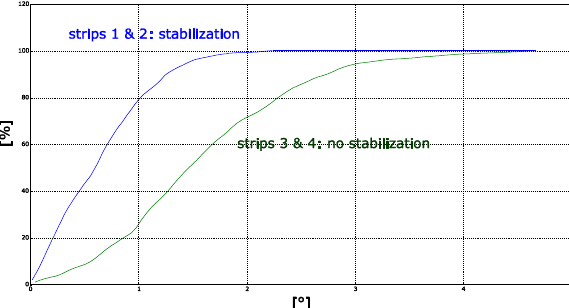
Figure 12. Empirical cumulative distribution function for pitch values. Flight #2.